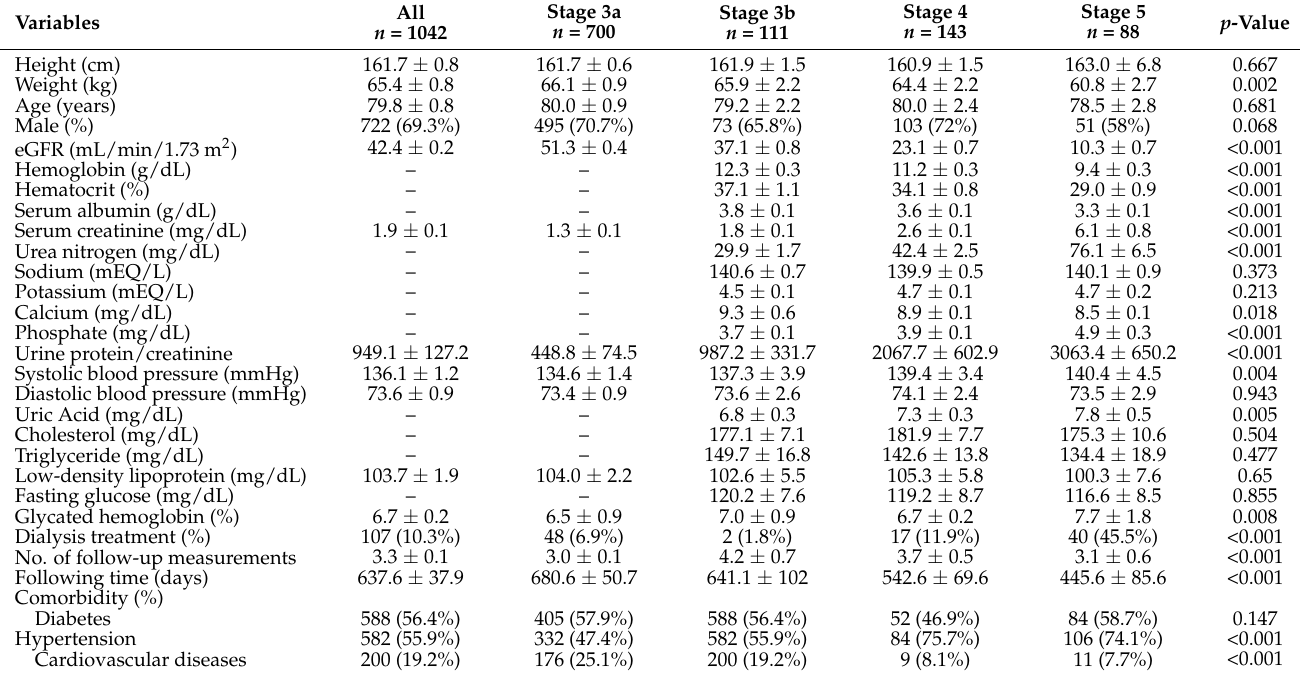
Table 1. Patient characteristics during the baseline stage of chronic kidney disease and dialysis treatment during the study period.